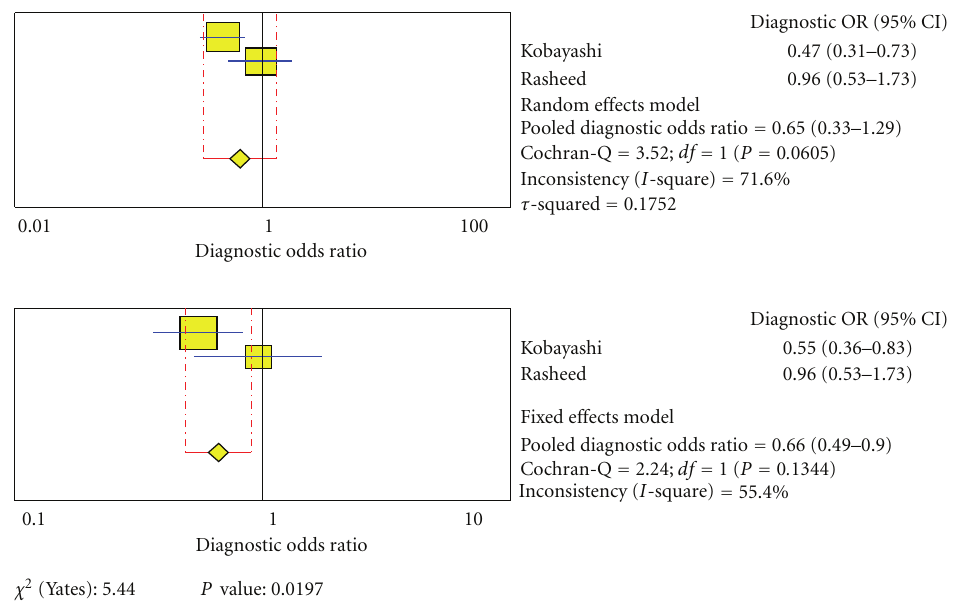
Figure 2: Risk of lymph node metastasis in males versus